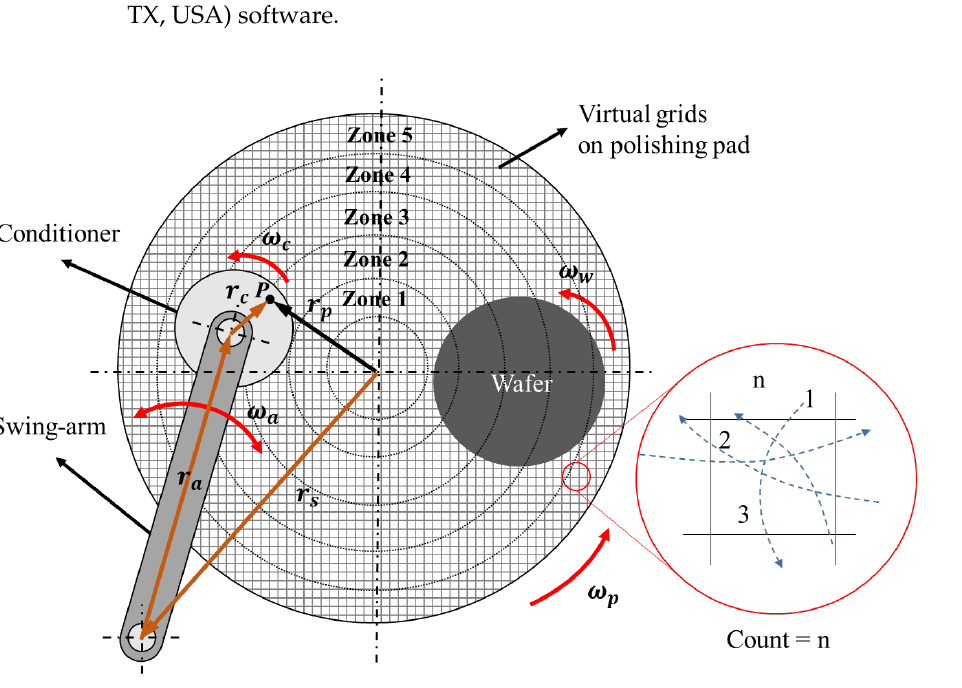
Figure 3. Schematic illustration of pad wear profile simulation.